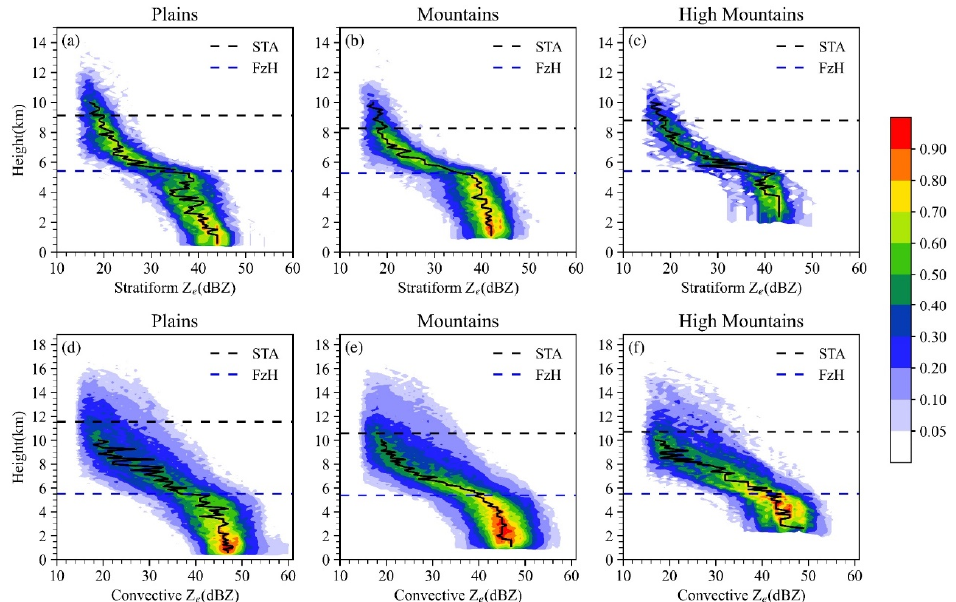
Figure 3. Normalized contoured frequency by altitude diagrams (NCFAD) of reflectivity factor of two types of heavy precipitation over plains ( a , d ), mountains ( b , e ), and high mountains ( c , f ). The color areas and black solid lines indicate occurrence frequency and maximum frequency profile of reflectivity factor, respectively. The black and blue dash lines represent STA and FzH, respectively.